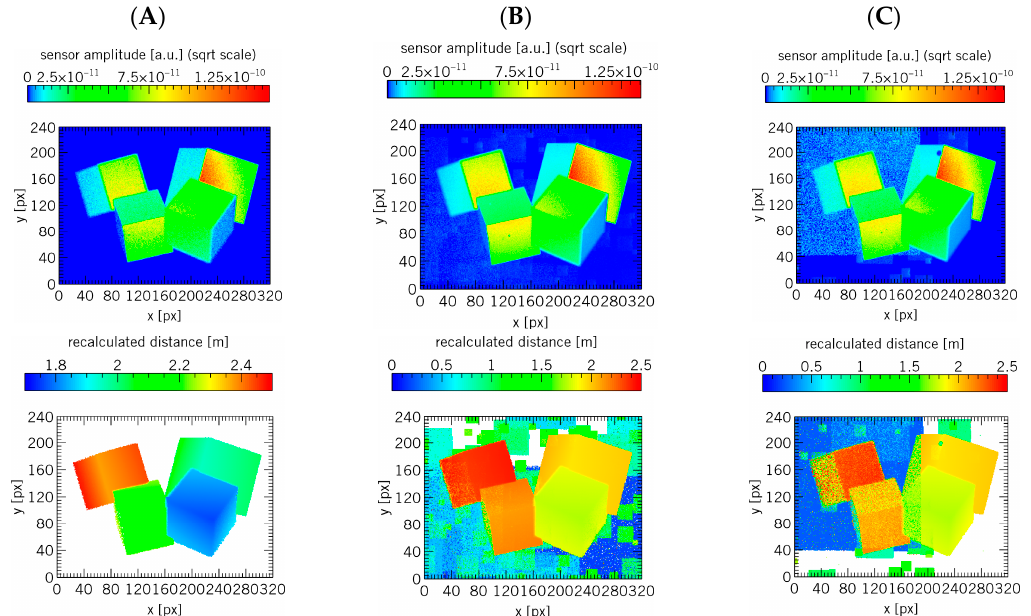
Figure 2. Intensity and depth plots for: ( A ) no rain between ToF camera sensor and the scene; ( B ) light rain (0.6 mm diameter particles, 1130 particles/m 3 ), ( C ) medium rain (1.3 mm diameter particles, 320 particles/m 3